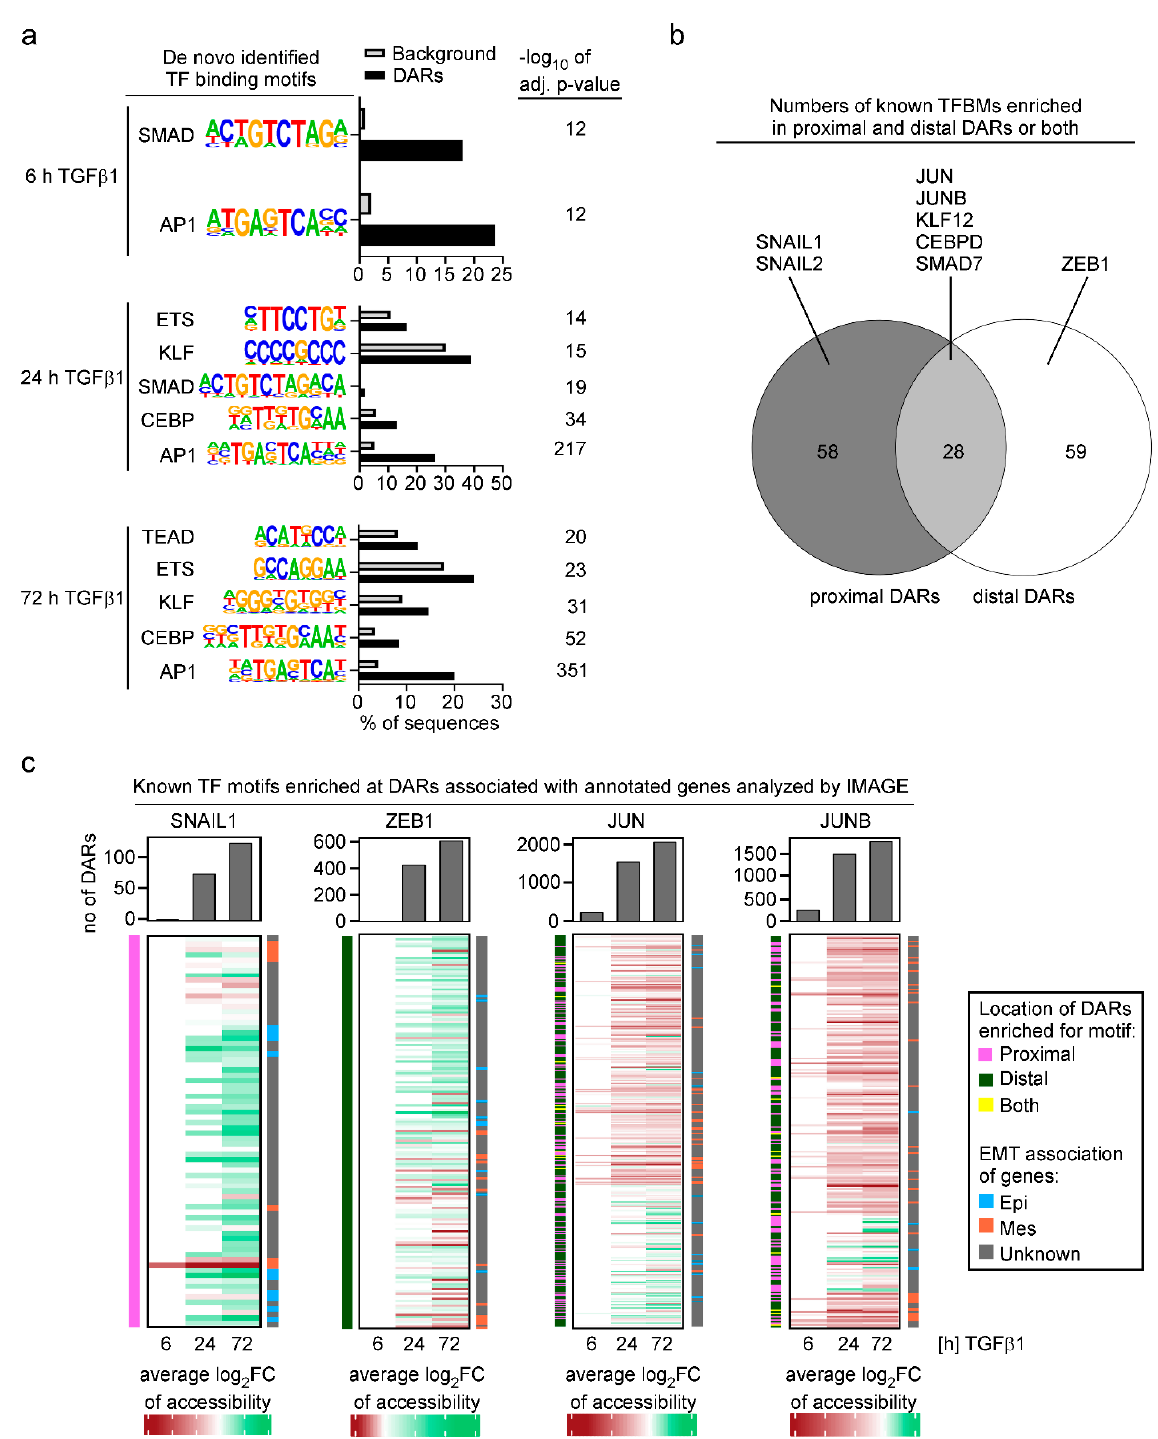
Figure 3. Analyses of TFBM activity suggests a prominent function for AP-1 family members JUN and JUNB in TGF β 1-induced EMT. ( a ) De novo motif analysis of DARs from the TGF β 1 time course experiment using HOMER. For each time point of the TGF β 1 treatment, all significantly identified TF motifs are shown. Bar plots display the percentage of DARs and random background genomics regions in which the motifs were enriched. Statistical significance is shown next to the